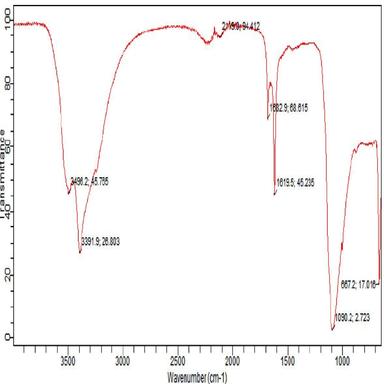
FTIR spectra of composite samples.